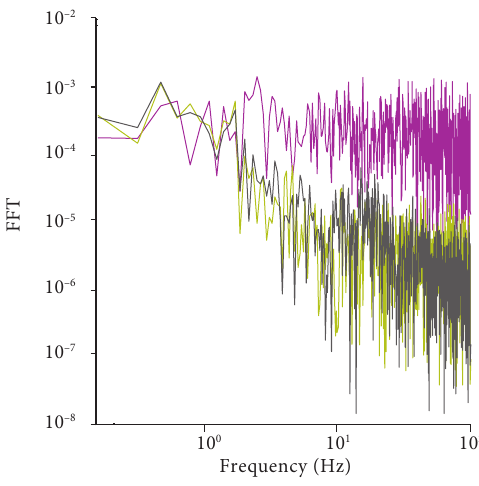
Figure 16. Sensors energy level at angle of attack of